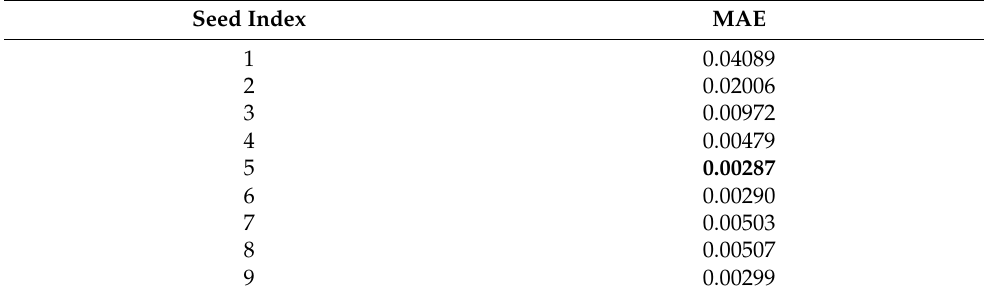
Table 1. MAE for the first 9 seed indexes of the 8-bit LFSR circuit. The minor value is highlighted in bold.